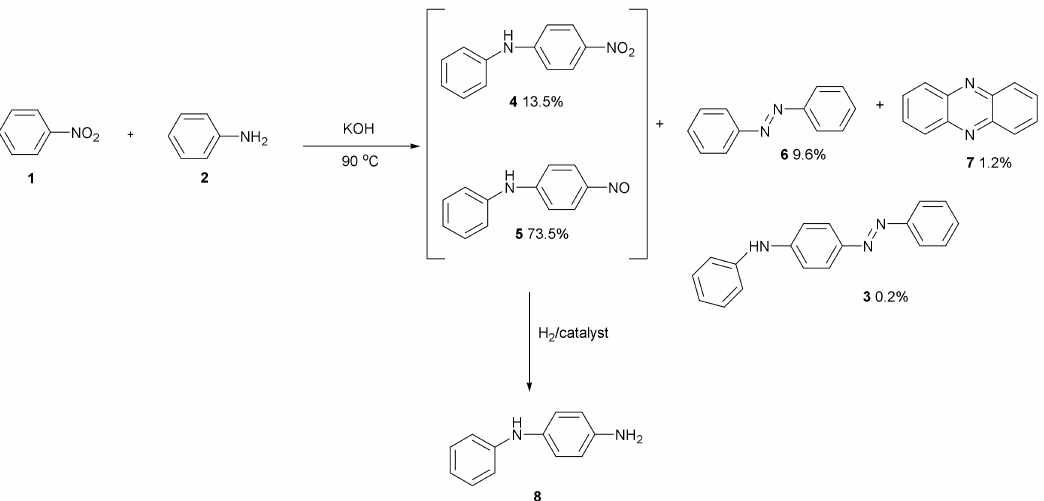
Figure 2. Anti-oxidant 8 formed from the KOH catalysed reaction of aniline with nitrobenzene followed by catalytic hydrogenation of products 4 and 5 .